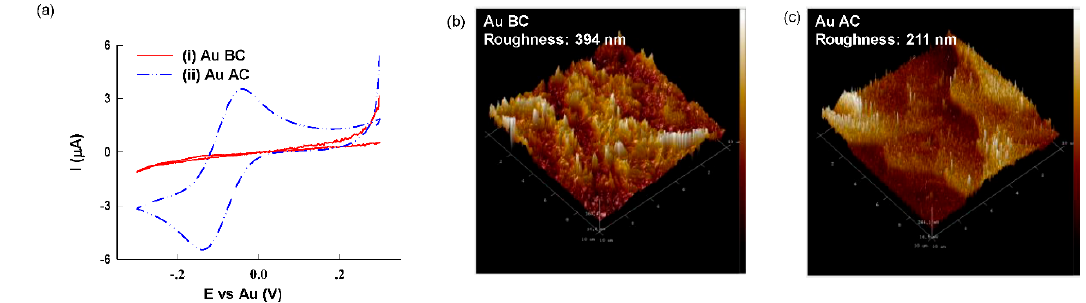
Figure 1. ( a ) Cyclic voltammograms obtained (at a scan rate of 50 mV/s) in a PBS solution containing 4 mM K 3 Fe(CN) 6 (i) before cleaning, (ii) after cleaning the Au plated PCB electrodes. ( b ) AFM of Au plated electrodes obtained ( b ) before cleaning, ( c ) after cleaning.